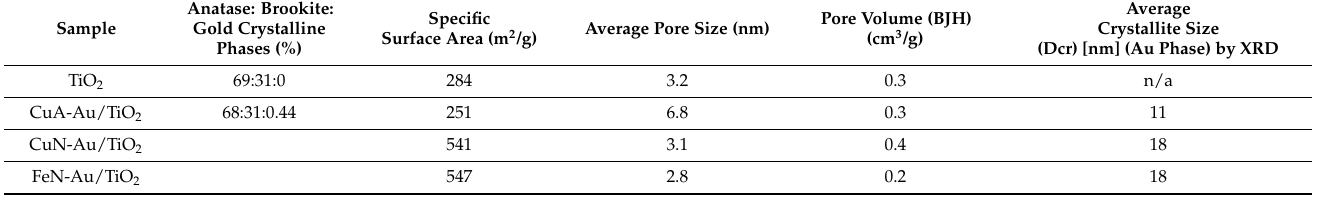
Table 1. Crystallographic, structural, and textural features of the synthesized bimetallic catalysts.